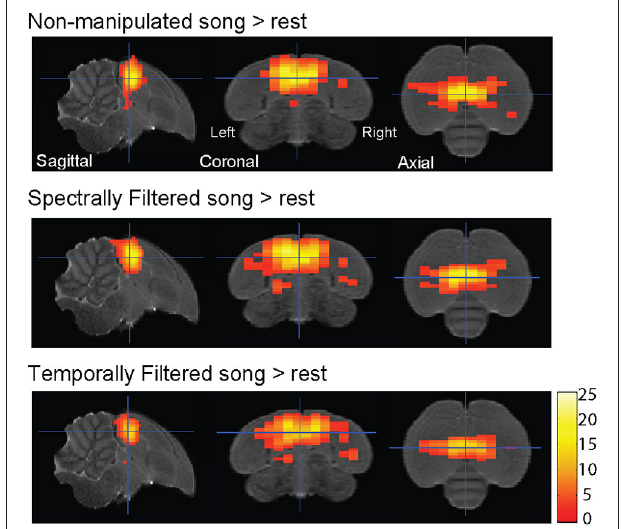
FIGURE 2 | Auditory forebrain activation in response to the different stimuli. Statistical maps are superimposed on images from the population based template. Only voxels with t > 2.76 (one sample t -test, p uncorrected < 0.005) are displayed ( n =